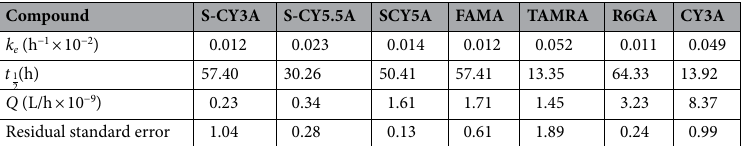
Table 2. Values of fluorescence independent PK parameters calculated by modelled data, and residual standard error. Compounds: S-CY3A (1), S-CY5.5A (2), S-CY5A (3), FAMA (4), TAMRA (5), R6GA (6) and CY3A (7). Confidence interval